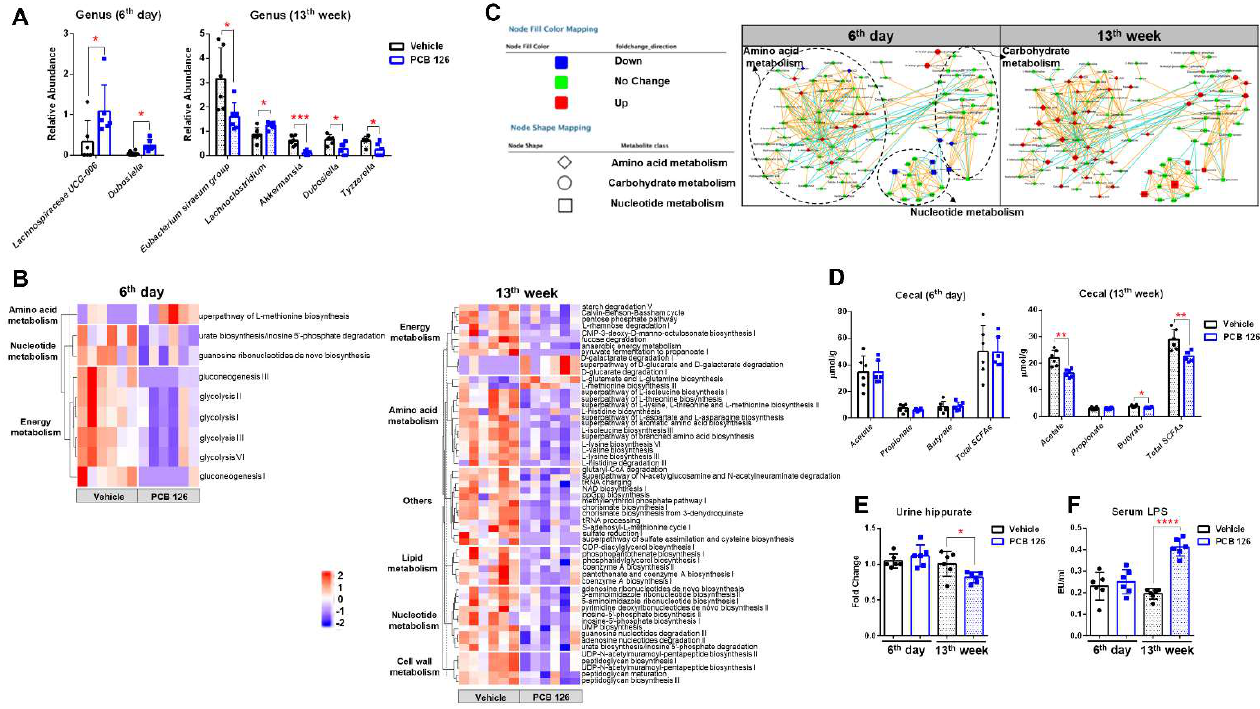
Figure 5. Effects of early life PCB 126 exposure on bacteria community, gene expression, and metabolism. ( A ) Relative abundance of cecal bacteria from genus that significantly changed from mice with vehicle or PCB 126 exposure. ( B ) Analysis of KEGG pathway abundance that significantly changed in the cecal microbiota from mice with vehicle or PCB 126 exposure. ( C ) Metabolic network changes in cecal bacteria from mice with vehicle or PCB 126 exposure. ( D , E ) NMR analysis of cecal short-chain fatty acids (SCFAs) ( D ) and urine hippurate ( E ) from mice with vehicle or PCB 126 exposure. ( F ) Serum lipopolysaccharide (LPS) levels from mice with vehicle or PCB 126 exposure. Values are means ± S.D. ( n = 6 per group). * p < 0.05, ** p < 0.01, *** p < 0.001, **** p < 0.0001 compared to vehicle.